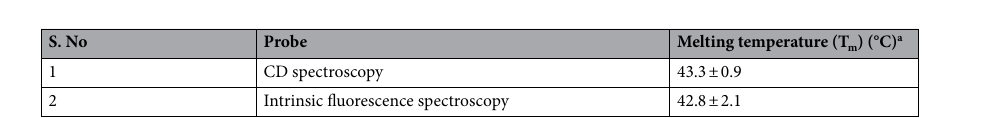
Table 1. Melting temperature (T m ) of AAR from thermal unfolding transition using different probes. a The values are mean of three measurements along with the standard error of the